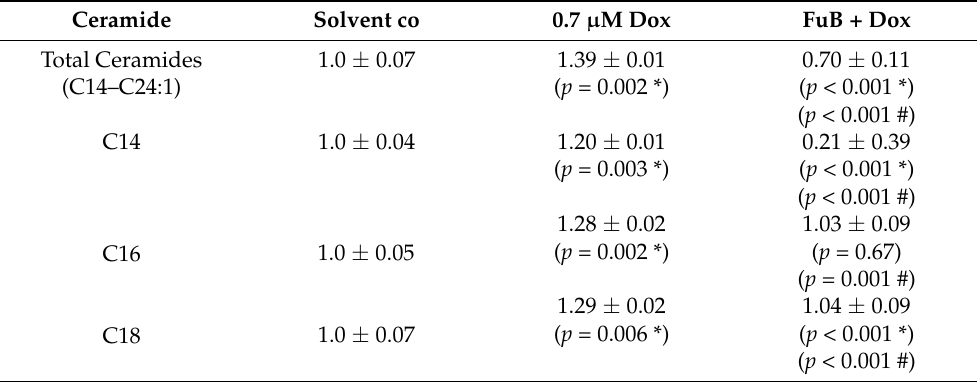
Table 1. ceramide levels in Dox treated and FuB pretreated